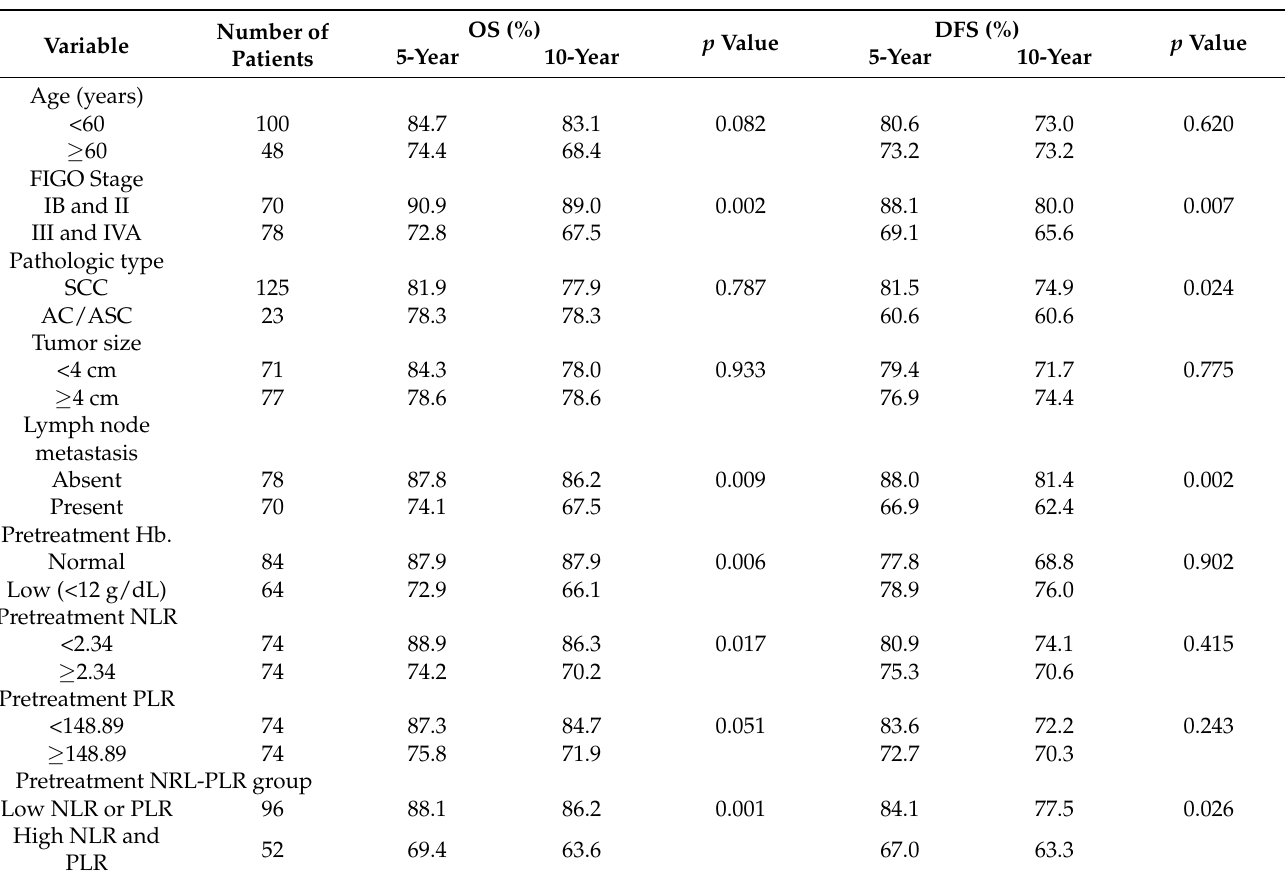
Table 3. Univariate survival